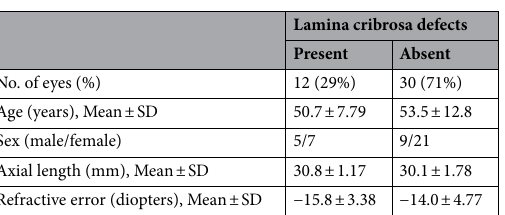
Table 1. Demographics of highly myopic eyes with and without lamina cribrosa defects. SD = standard